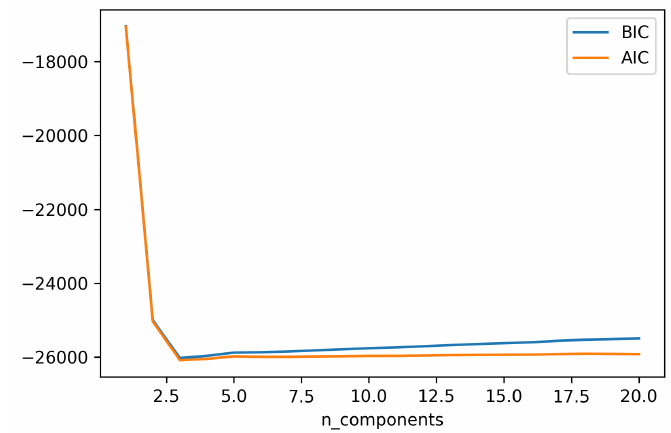
Figure 14. AIC/BIC for curves for number of